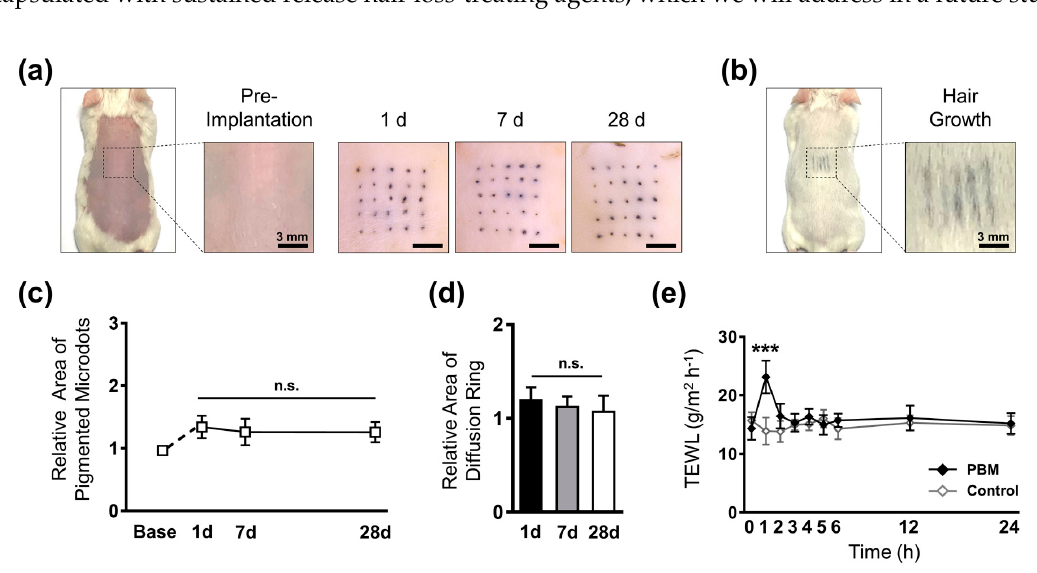
Figure 4. In vivo assessment of micro-pigment-encapsulated biodegradable microneedles (PBMs) in mice. (a) The dorsal skin of mice was shaved and implanted with PBMs. The visual intensity of the micro-pigments was maintained up to 28 days post-implantation. ( b ) Micro-pigments were visible on the dorsal skin after hair growth. ( c ) The dimension of microdots were expanded on day 1 and declined from day 7. ( d ) Diffusion rings surrounding the microdots were relatively small, with no significant alternations over time. ( e ) Transepidermal water loss (TEWL) analysis of mice at the implantation site confirmed that skin barrier functionality was restored at 2 h post-implantation with PBMs. Data in ( c ), ( d ), and ( e ) are expressed as the mean ± SEM. * p < 0.05, and *** p < 0.001.